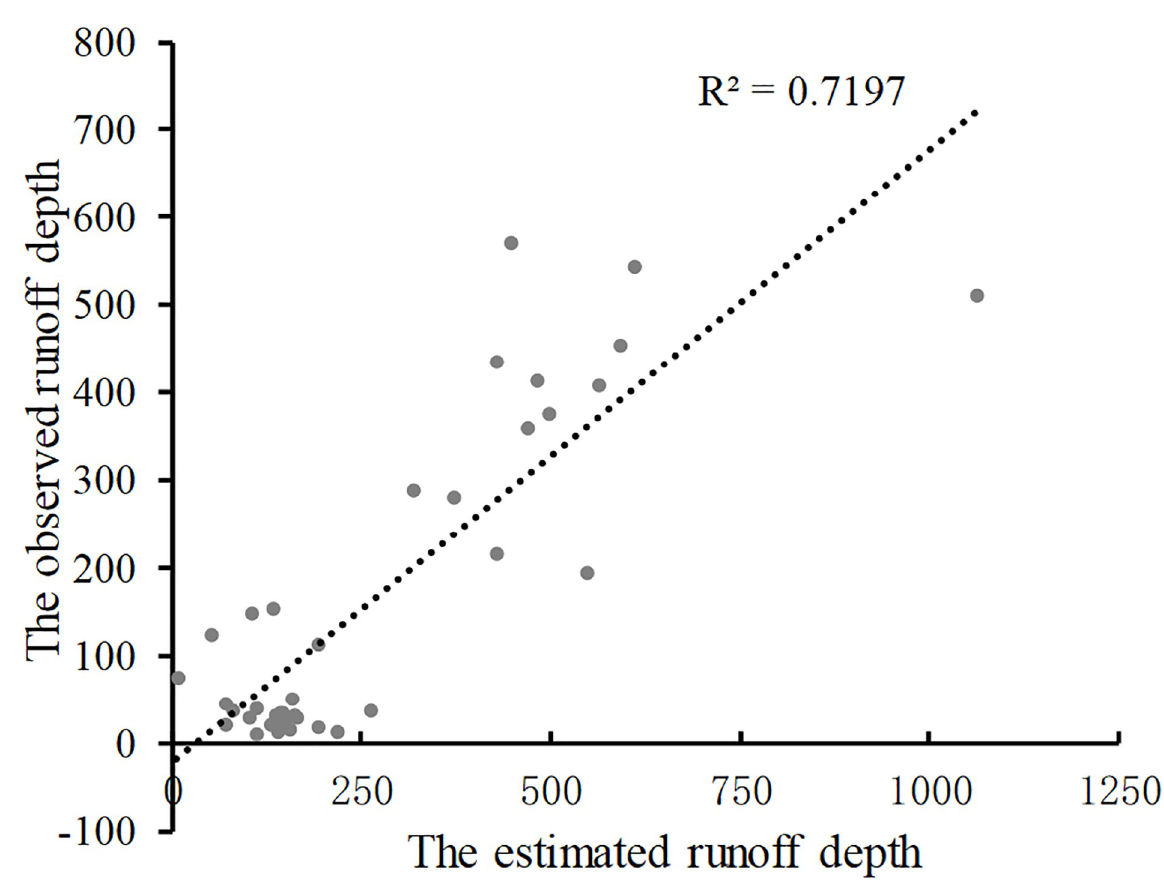
Fig 3. Relationship of the observed and estimated runoff